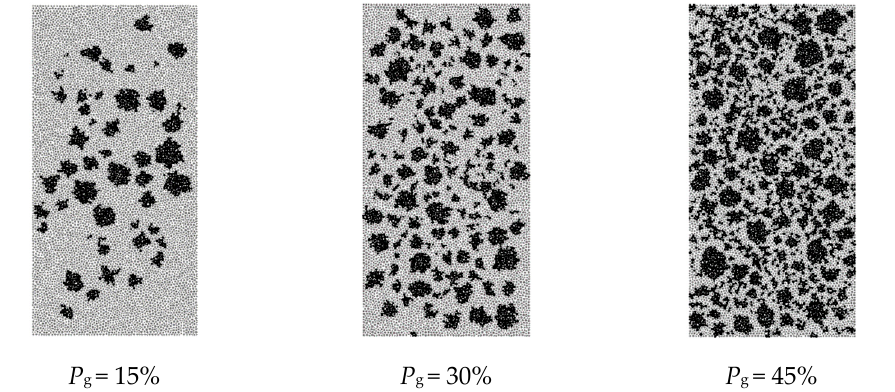
Figure 7. Pebbly sandstone samples with di ff erent gravel contents.